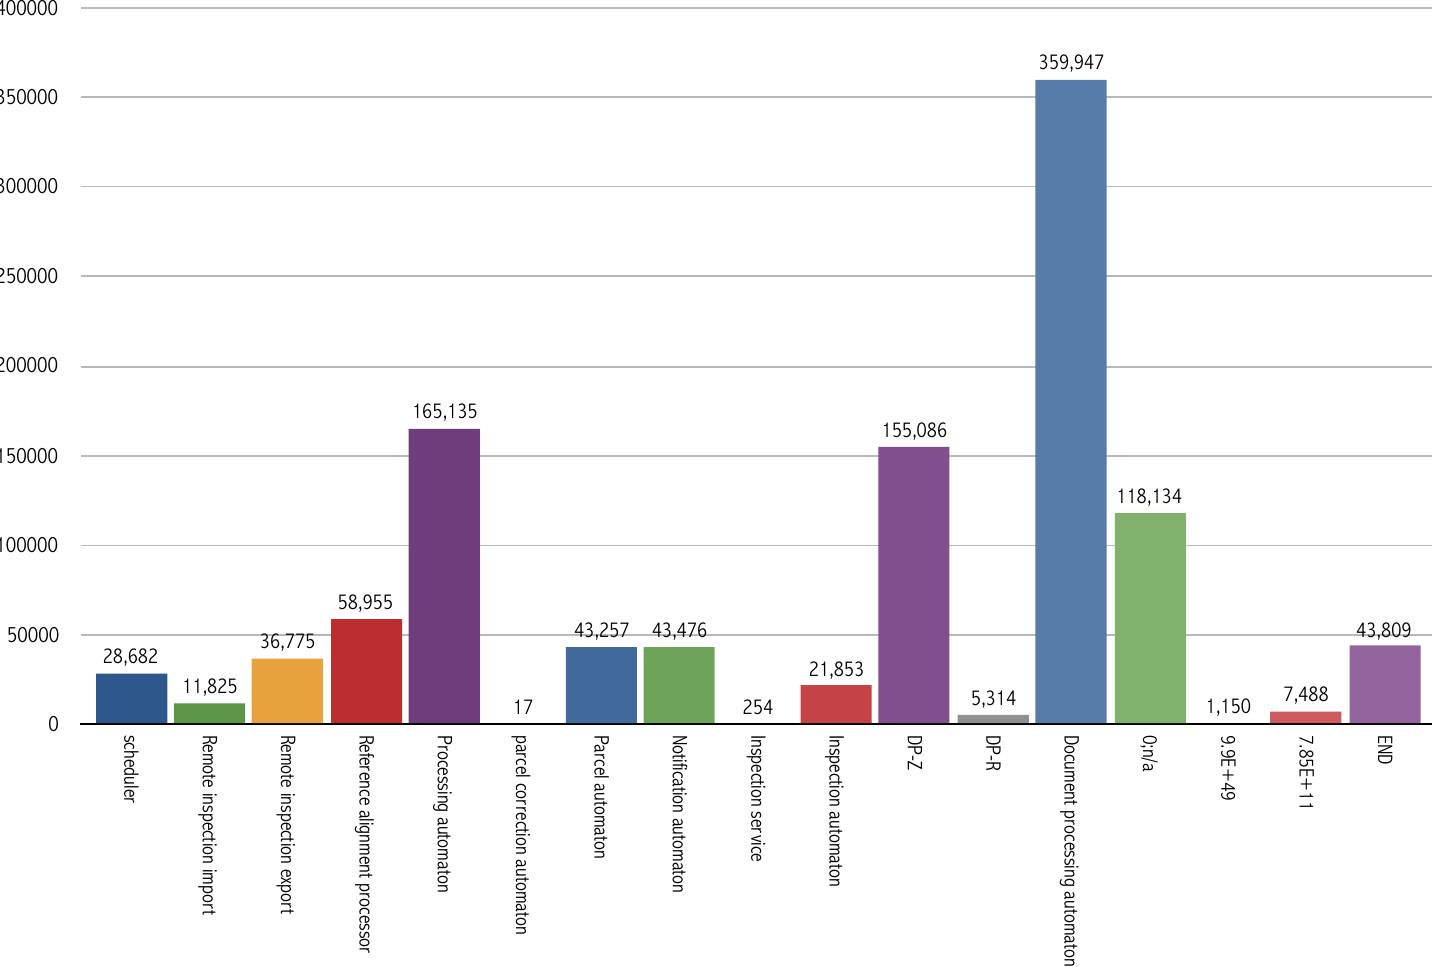
Figure 11. Automatic programs without human interference and their